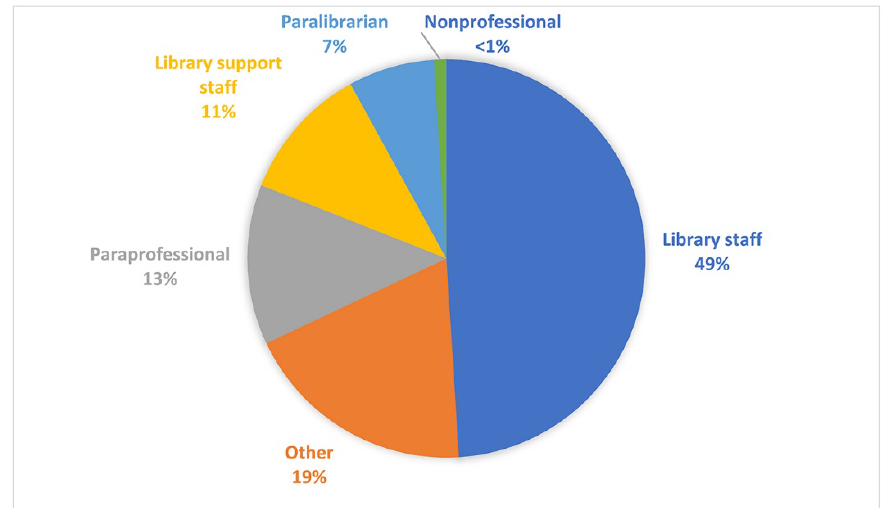
Figure 1 Participants’ top choices for term preferences